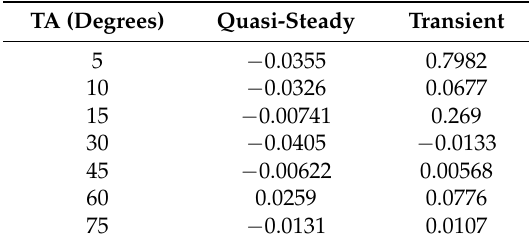
Table 7. Wing lift coefficients by both methods.